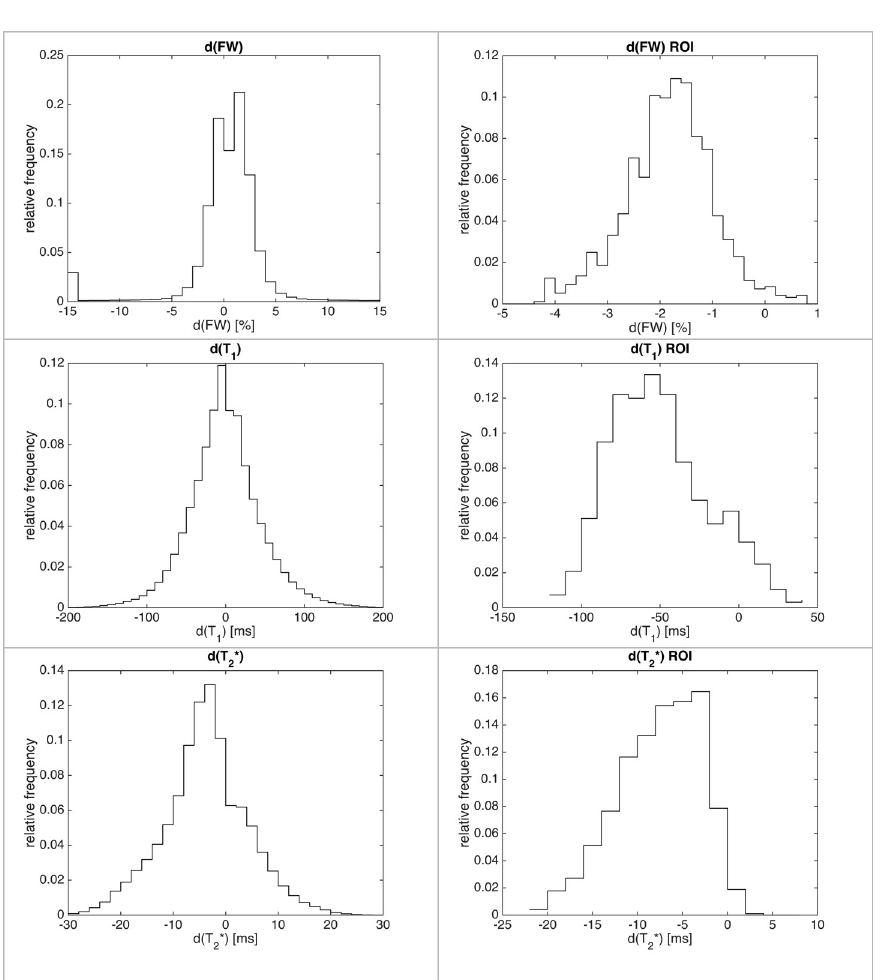
Fig 3. Normalised histograms of differences for all voxels (left column) and inside the ROI (right column). The shift towards the negative values is more apparent inside the ROI. Notice that histograms are cropped for readability and hence do not show outliers.